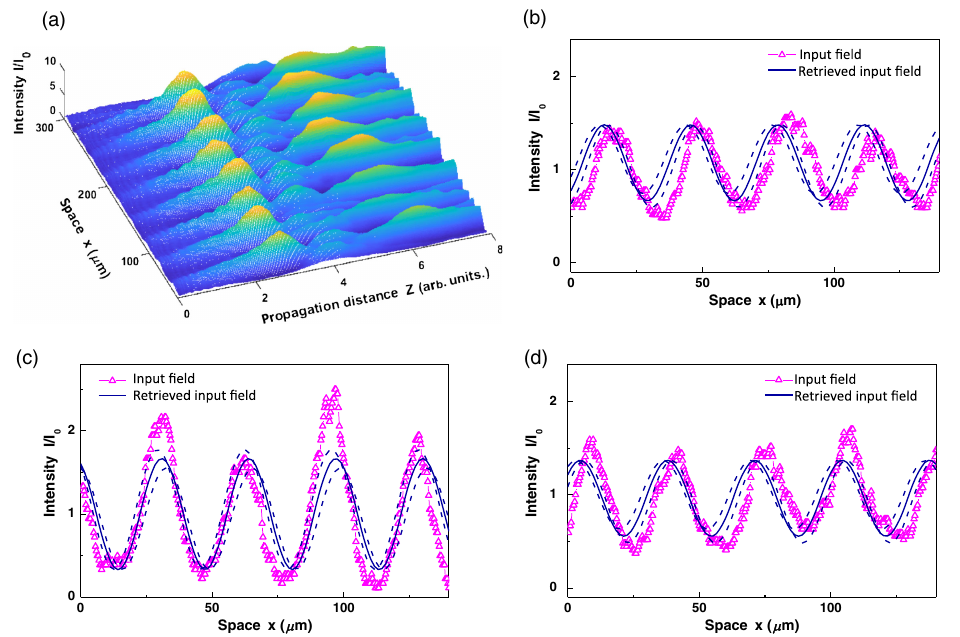
FIG. 4. Inverse problem. (a) Experimental observation used to test the predictability of the input state from the recurrent dynamics ( k ¼ 0 . 021 μ m − 1 ). We show measured (dots) and retrieved (line) input fields for different initial phases: (b) ϕ ≃ π , (c) ϕ ≃ 0 , and (d) ϕ ≃ 0 . 3 π . Dashed lines indicate the uncertainty of the retrieved